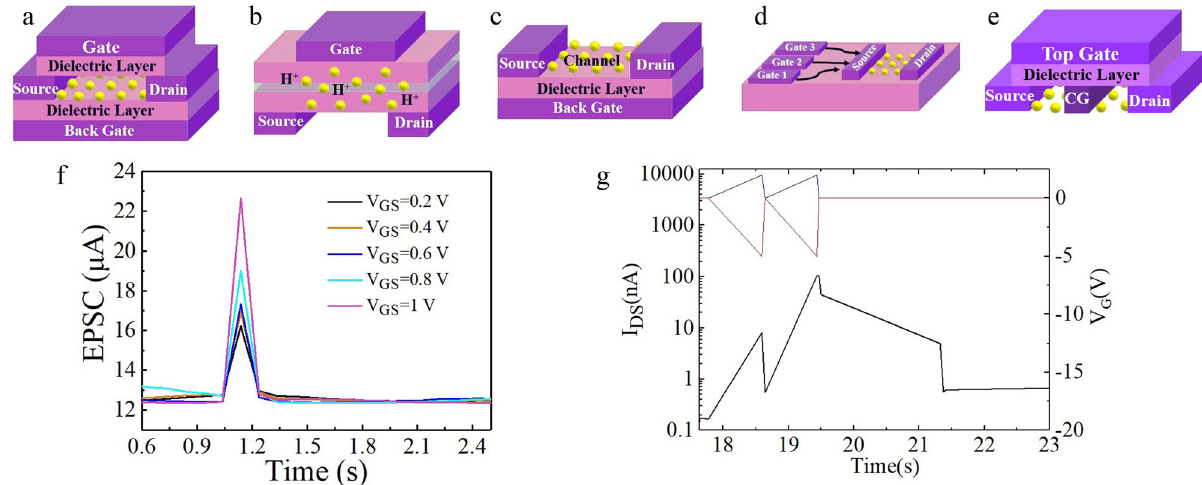
Fig. 5 Comparison of the arti fi cial synaptic structures and characteristics. a – d Previously published arti fi cial synaptic transistor structures 22 , including a transistor with bottom gate and top gate, b transistor with additional channel materials or layers, c transistor with the bottom gate, and d transistor with multiple side gates and a large footprint. e Structure of the proposed one-transistor arti fi cial synaptic device, which does not contain any additional dielectric, conducting layer or side gate. f Effect of control gate voltage V CG on the arti fi cial synaptic transmission behavior. g Weight modulations of the arti fi cial synaptic structures with PPF and potentiation (the curves in blue, red, and black are the top gate voltage, the control gate voltage, and I DS ,